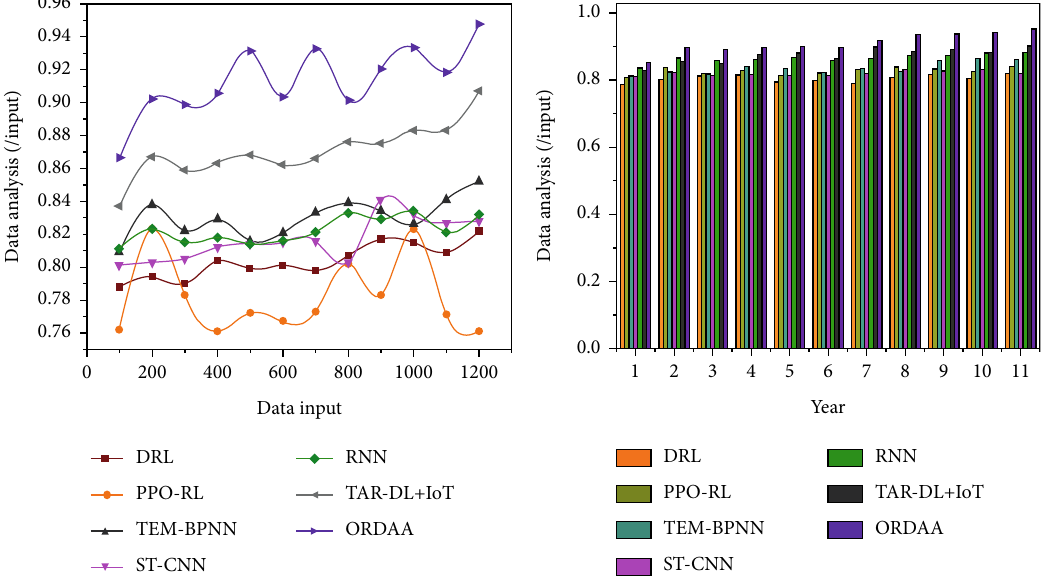
Figure 11: Data analysis comparison.